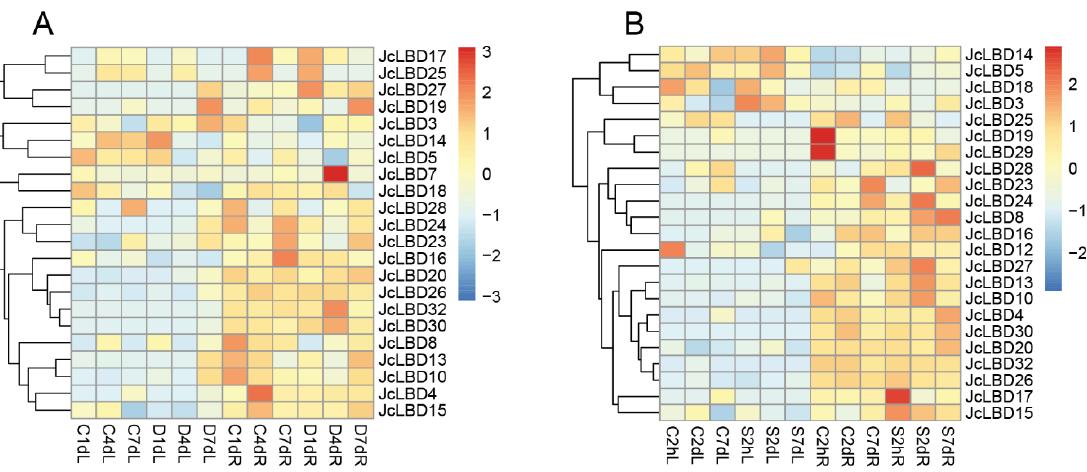
Figure 8. Stress response analysis of LBD s in Jatropha curcas . ( A ) Expression of JcLBD s in drought treatment. C and D represent control and drought treatments, respectively, and 1d, 4d and 7d correspond to one, four, and seven days post-treatment sampling, respectively, and L and R represent leaf and root tissues, respectively. ( B ) Expression of JcLBD s under salt stress. C and S represent control and salt stress treatments, respectively, 2h, 2d and 7d correspond to 2 h, two days and seven days post-treatment sampling, respectively, and L and R represent leaf and root tissues, respectively. Heatmap was drawn by pheatmap using log10(TPM) values.